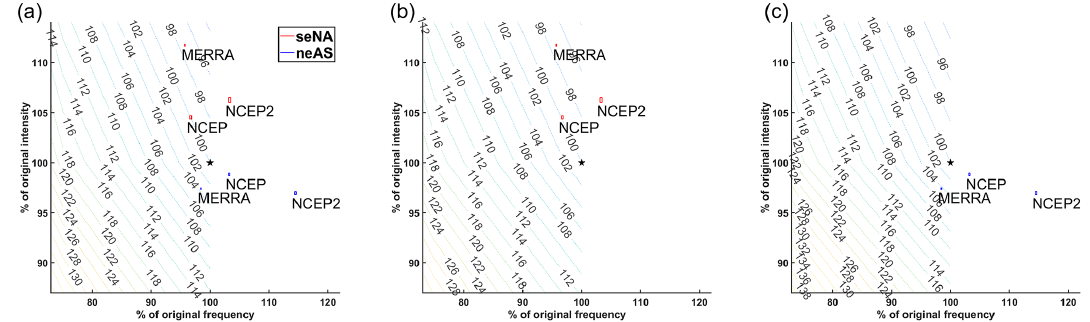
Figure 6. Comparison of the contours calculated on global and regional scales: (a) global, (b) southeastern North America (seNA), and (c) northeastern Asia (neAS). The contours indicate the atmospheric lifetimes of the black carbon aerosols from the interpolation of 20 cases and show the potential changes of BC lifetimes from the base BC lifetime (in the control run) driven by the changes of precipitation intensity and frequency. The contour calculated on the global scale is the same as Fig. 2. The seNA and neAS regions are two most extreme cases among all regions, with the smallest and largest sensitivities between BC lifetimes and precipitation